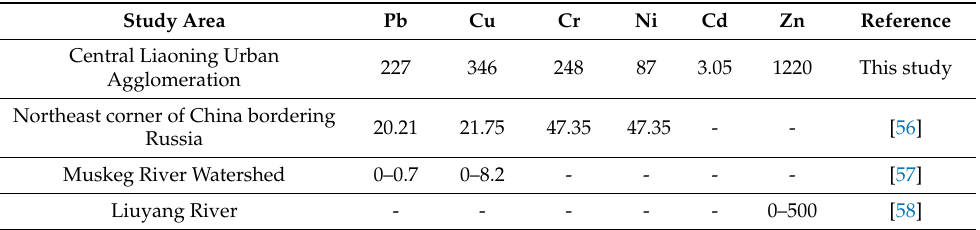
Table 2. Comparison of the contribution of heavy metal pollutant loads obtained in this study and previous publications, units (g/ha ·